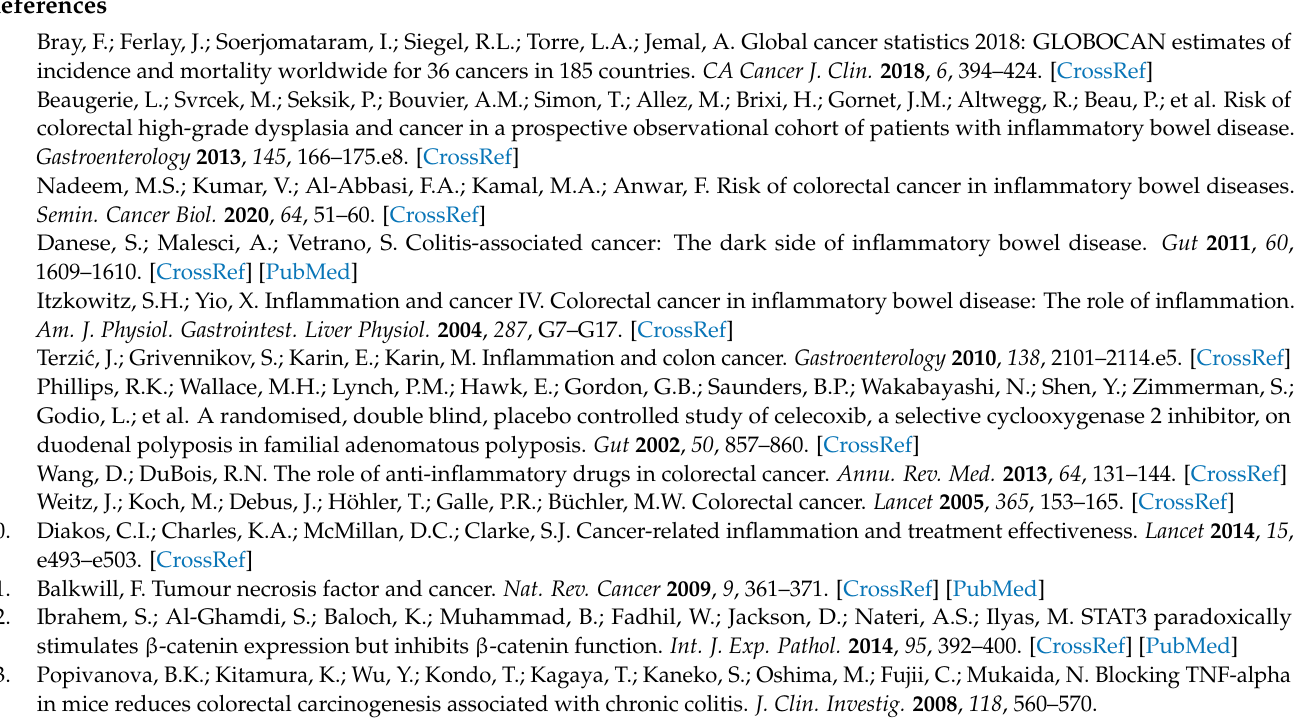
groups; Table S1: The nutritional composition of BL; Table S2: The nutritional composition of experimental diet; Table S3: The sequence of